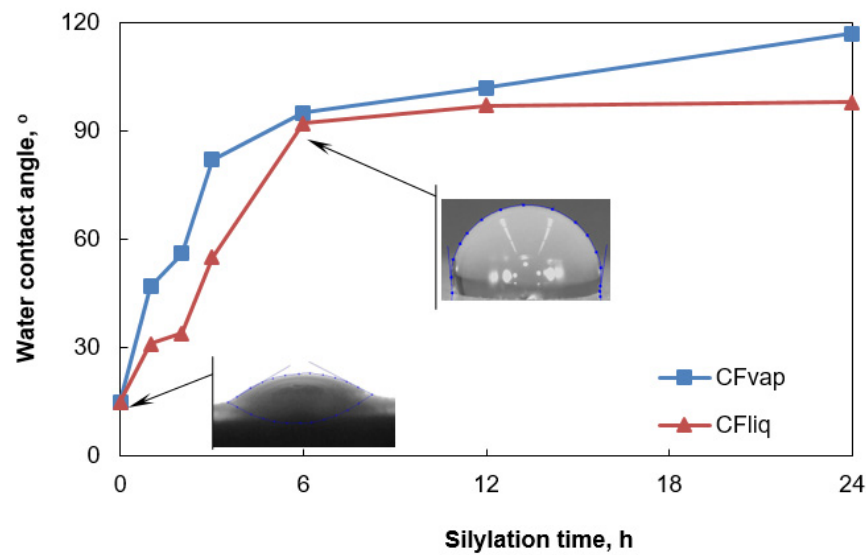
Figure 8. E ff ect of silylation time and technique on the water contact angle of CF powders. Coatings 2020 , 10 , x FOR PEER REVIEW